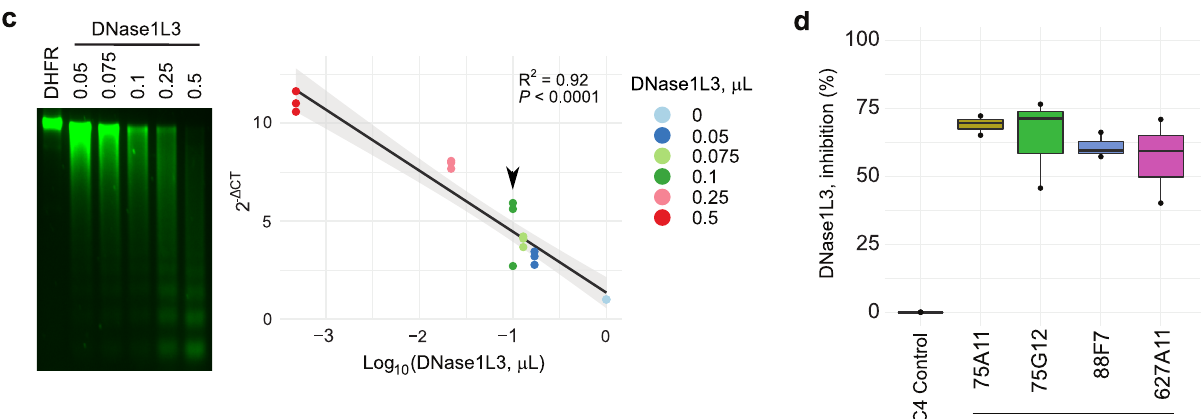
Fig. 4 | Origin and functional characterization of SLE patient-derived mono- clonal antibodies to DNase1L3. a Radiolabeled DNase1L3 was immunoprecipi- tated (IP) with anti-DNase1L3 positive SLE sera with (+) and without ( − ) immunoglobulin (Ig) depletion using 9G4 monoclonal antibodies. Radiolabeled DNase1L3inimmunecomplexeswasquanti fi edbydensitometryandanti-DNase1L3 antibodydepletion wasexpressedaspercentage according to theircorresponding 9G4non-depleted serum. b Iggene usage, mutationnumber and CDR3amino acid sequences of monoclonal antibodies to DNase1L3. c Increasing amounts of recombinant DNase1L3 (PURExpress) were incubated with puri fi ed intact